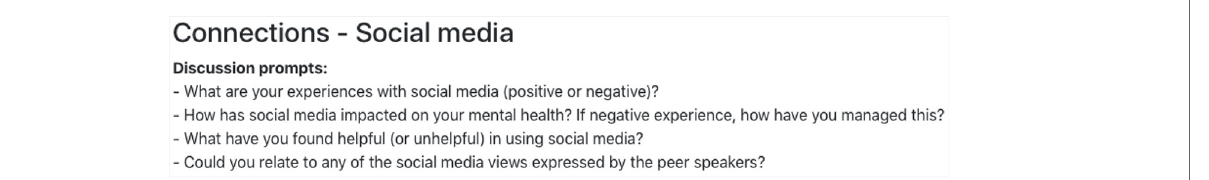
FIGURE 3 | Example of the connections module in Peer